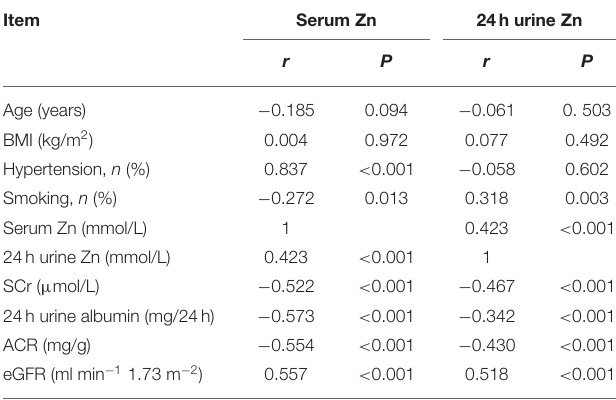
TABLE 6 | Correlation coefficients between Zn and clinical characteristics and indices of renal function in DN